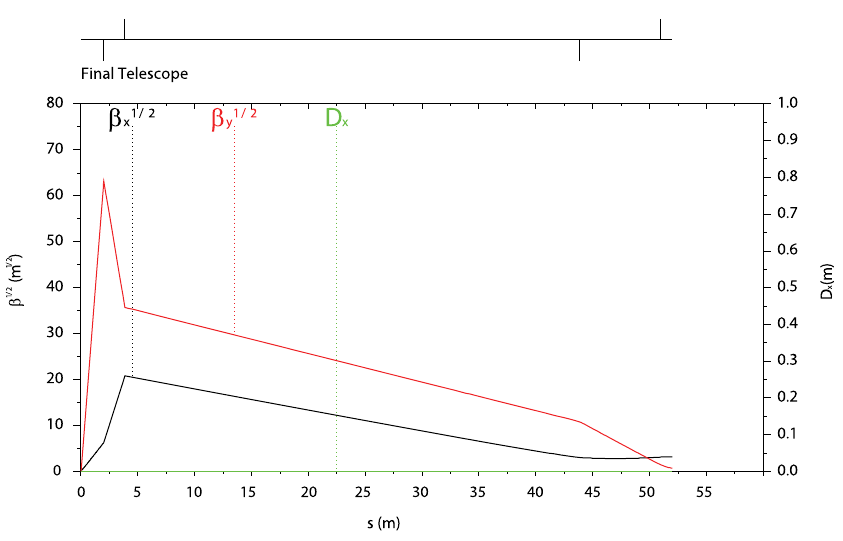
FIG. 5. The Courant-Synder parameters in a final telescope with demagnification factors M : 10 and 25 in the horizontal and vertical planes respectively. The parameters are L (cid:2) ¼ 2 m, L ¼ 40 m, L 2 ¼ 1 m, β (cid:2) x ¼ 0 . 1 m, and β (cid:2) y ¼ 1